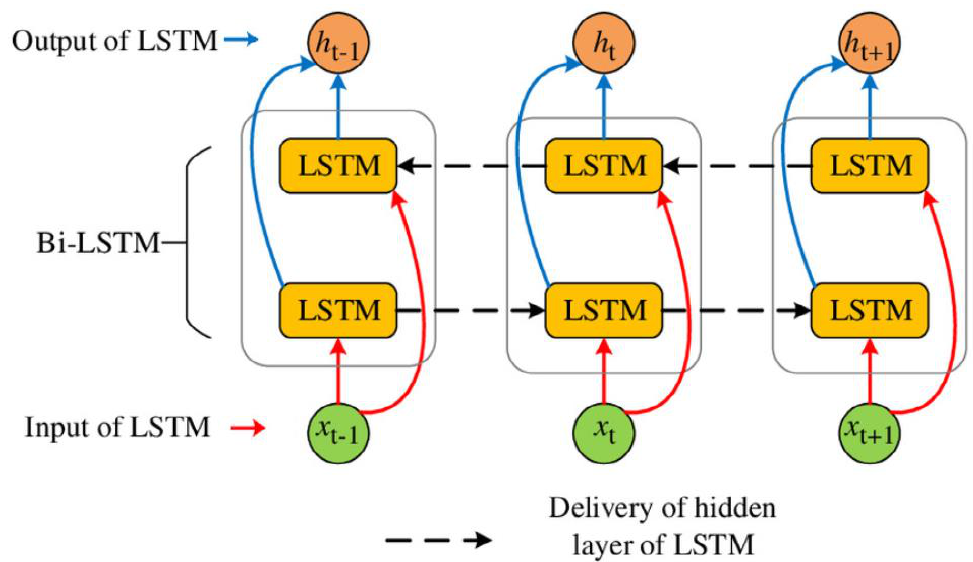
Figure 5. Architecture of Deep Neural Network (Bi-LSTM) (adapted from Zaremba et al. [53]).